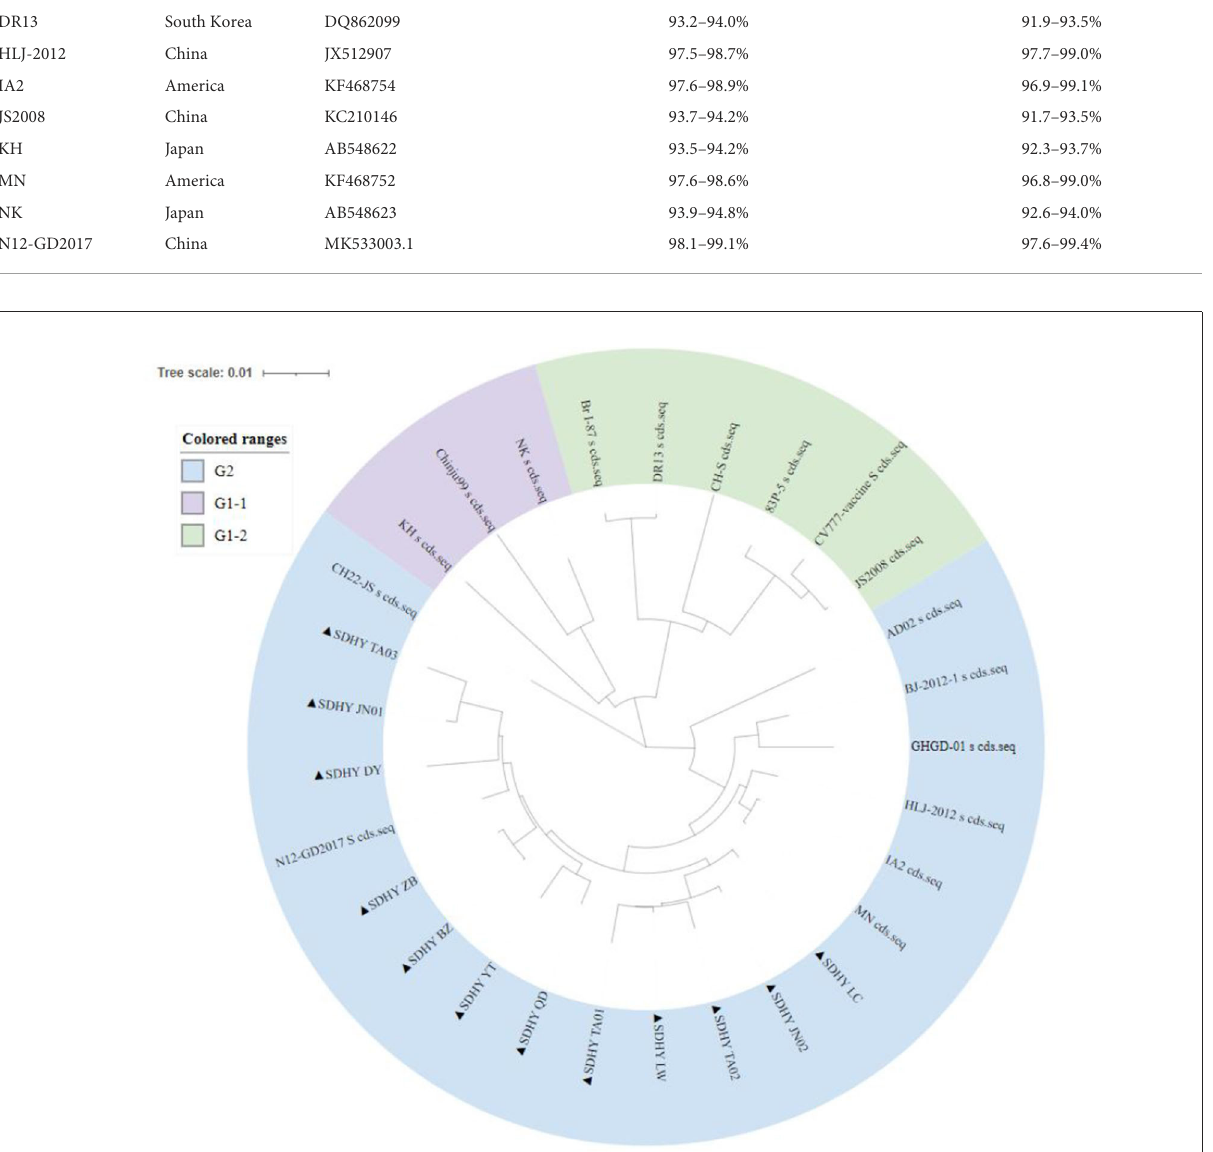
FIGURE6 A phylogenetic tree based on the nucleotide construction of the PEDV S gene. “Purple” represents G1-1 subtype, “green” represents G1-2 subtype and “blue” represents G2 subtype. “ N ” represents the isolates obtained in this